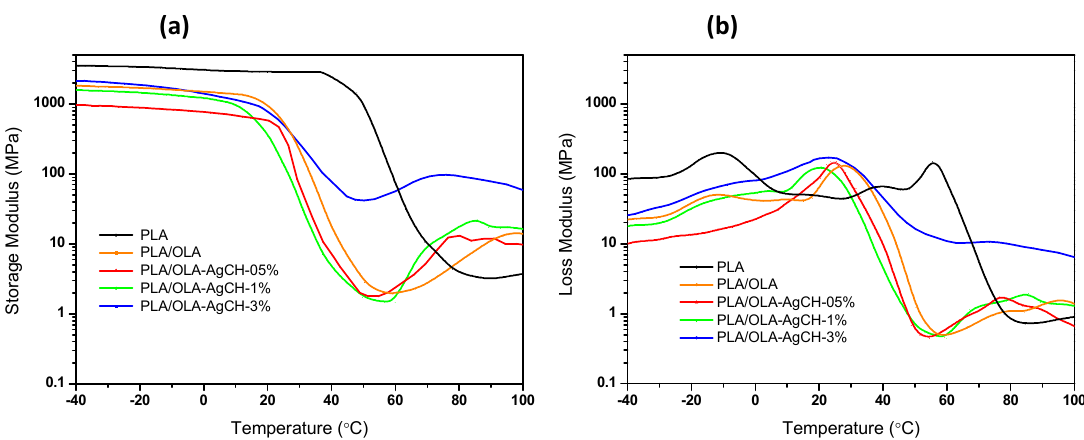
(cid:48) ) and ( b ) loss modulus (E”) as a function of Figure 4. Evolution of ( a ) storage modulus (E´) and ( b ) loss modulus (E´´) as a function of temperature. Figure 4. Evolution of ( a ) storage modulus (E